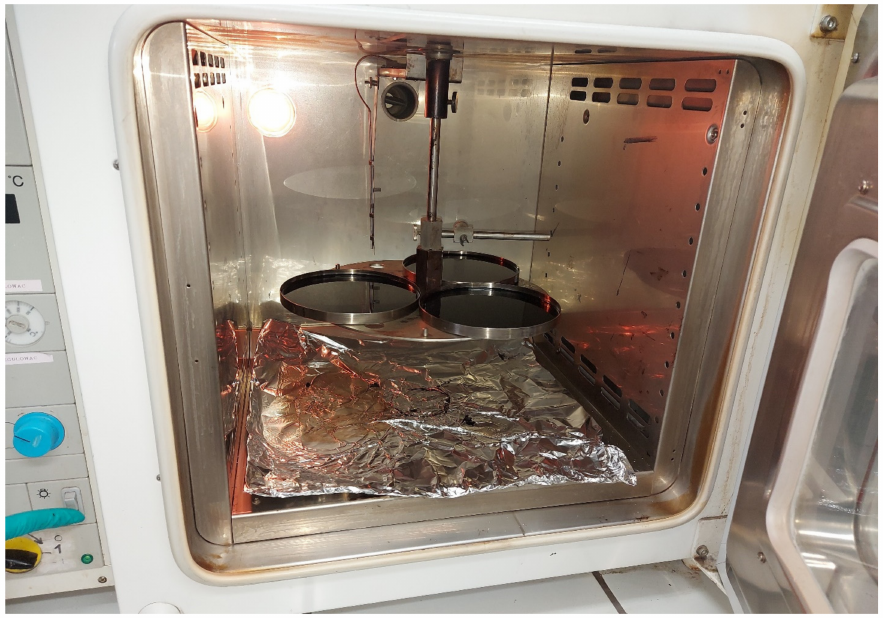
Figure 4. Photograph of a set of pans and an oven for aging bitumen by the TFOT